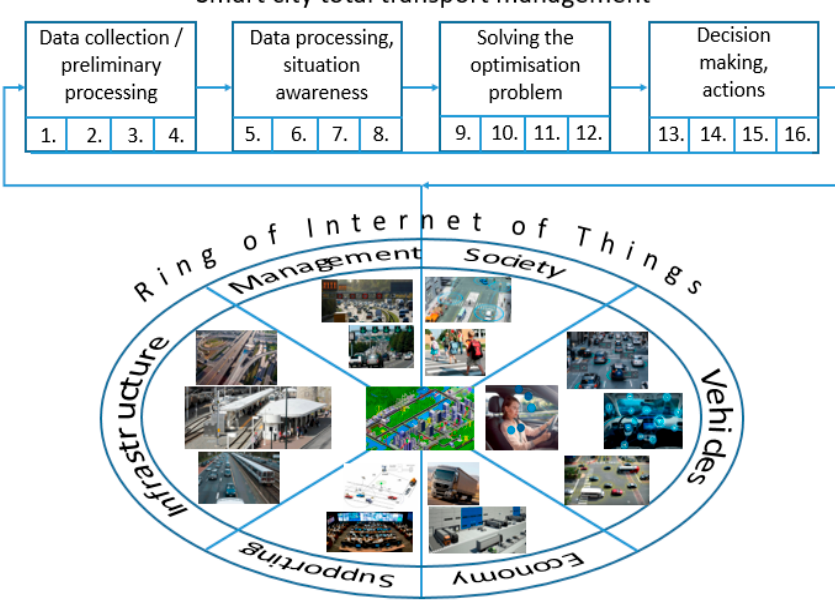
Figure 4. Representation of management with smart city total transportation system.